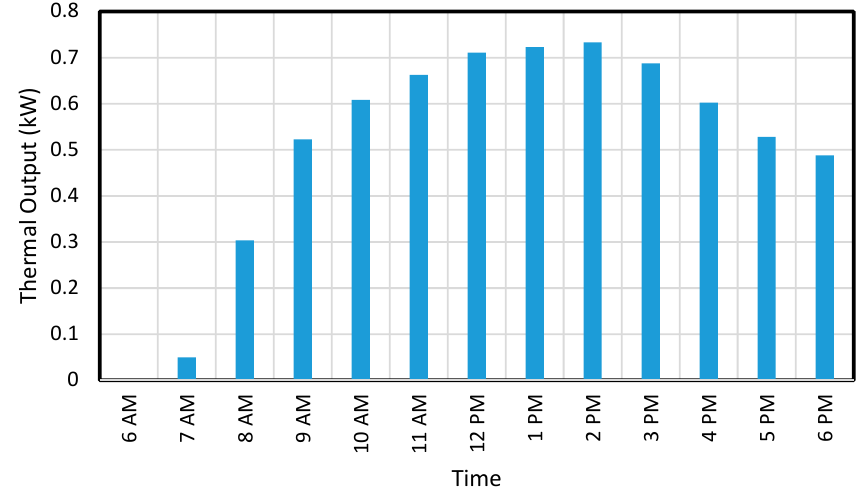
Figure 10. Thermal output of the PV-FPCM system.